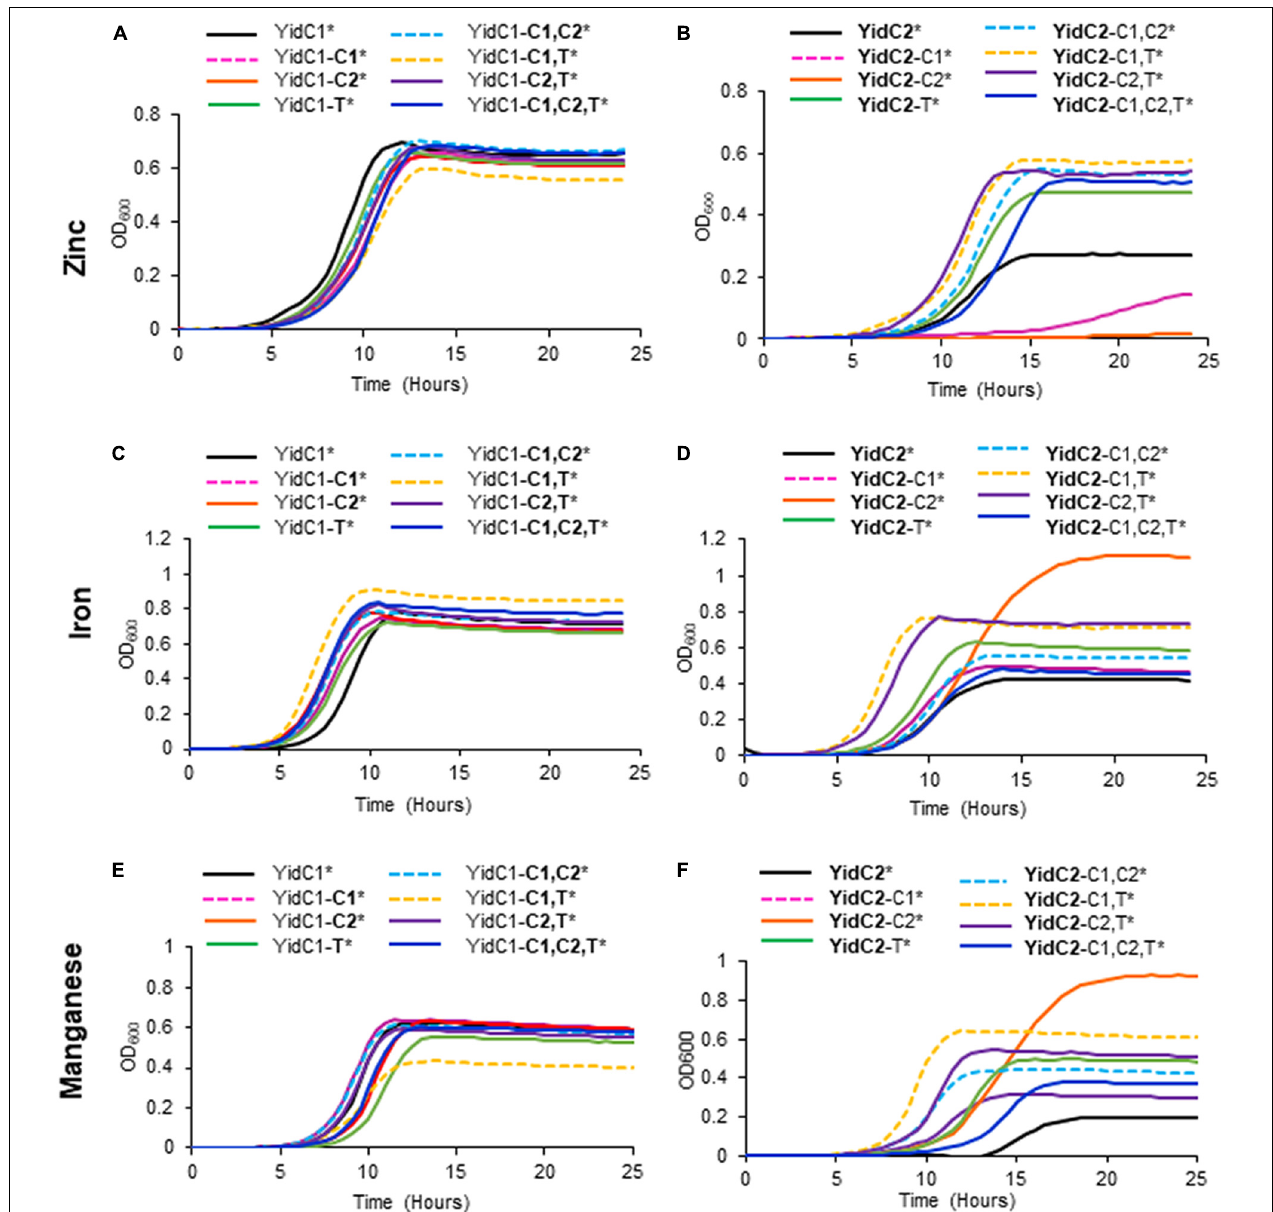
FIGURE 6 | Effect of YidC1/2 cytoplasmic domain substitutions on S. mutans growth under excess transition metal conditions. Growth of strains complemented by ectopic expression (*) from the gtfA locus of unmodified yidC1 (A,C,E) or yidC2 (B,D,F) compared to corresponding cytoplasmic domain (CD) swap variants in a double (cid:49) yidC1/ (cid:49) yidC2 background. (A,B) Growth in THYE, pH 7, supplemented with 2.5 mM ZnCl 2 under aerating conditions. (C,D) Growth in THYE, pH 7, supplemented with 5 mM MnCl 2 under aerating conditions. (E,F) Growth in THYE, pH 7, supplemented with 5 mM MnCl 2 under aerating conditions. Growth measurements were carried out at least three times with each sample assayed in triplicate. Data shown are mean replicates of an independent experiment. Regular text indicates YidC1 backbone or CD. Bold text indicates YidC2 backbone or